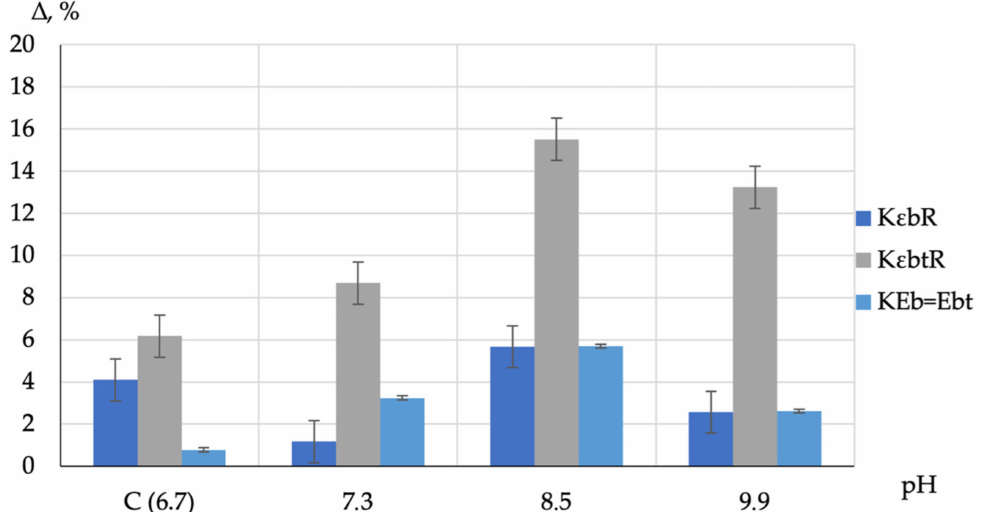
Figure 4. Dependence of the change in the coefficients of the strain variatropic efficiency of vibro- centrifuged concretes on the pH level of activated water (see Figure 3; C is the control composition; ∆ is the value of the change in the coefficients of the strength variatropic